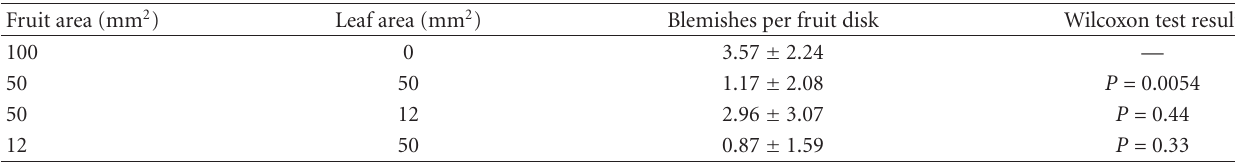
Table 2: Blemishing by D. hesperus females on fruit disks of di ff erent sizes in Petri dish arenas with di ff erent combinations of leaf and fruit tissue available. The observed blemishes on fruit in arenas containing two di ff erent tissue types were subtracted from the area-adjusted prediction for blemishes from the arenas with only fruit tissue, and tested by Wilcoxon signed-rank test to determine if this di ff erence deviated from zero. N = 30 for all tests.